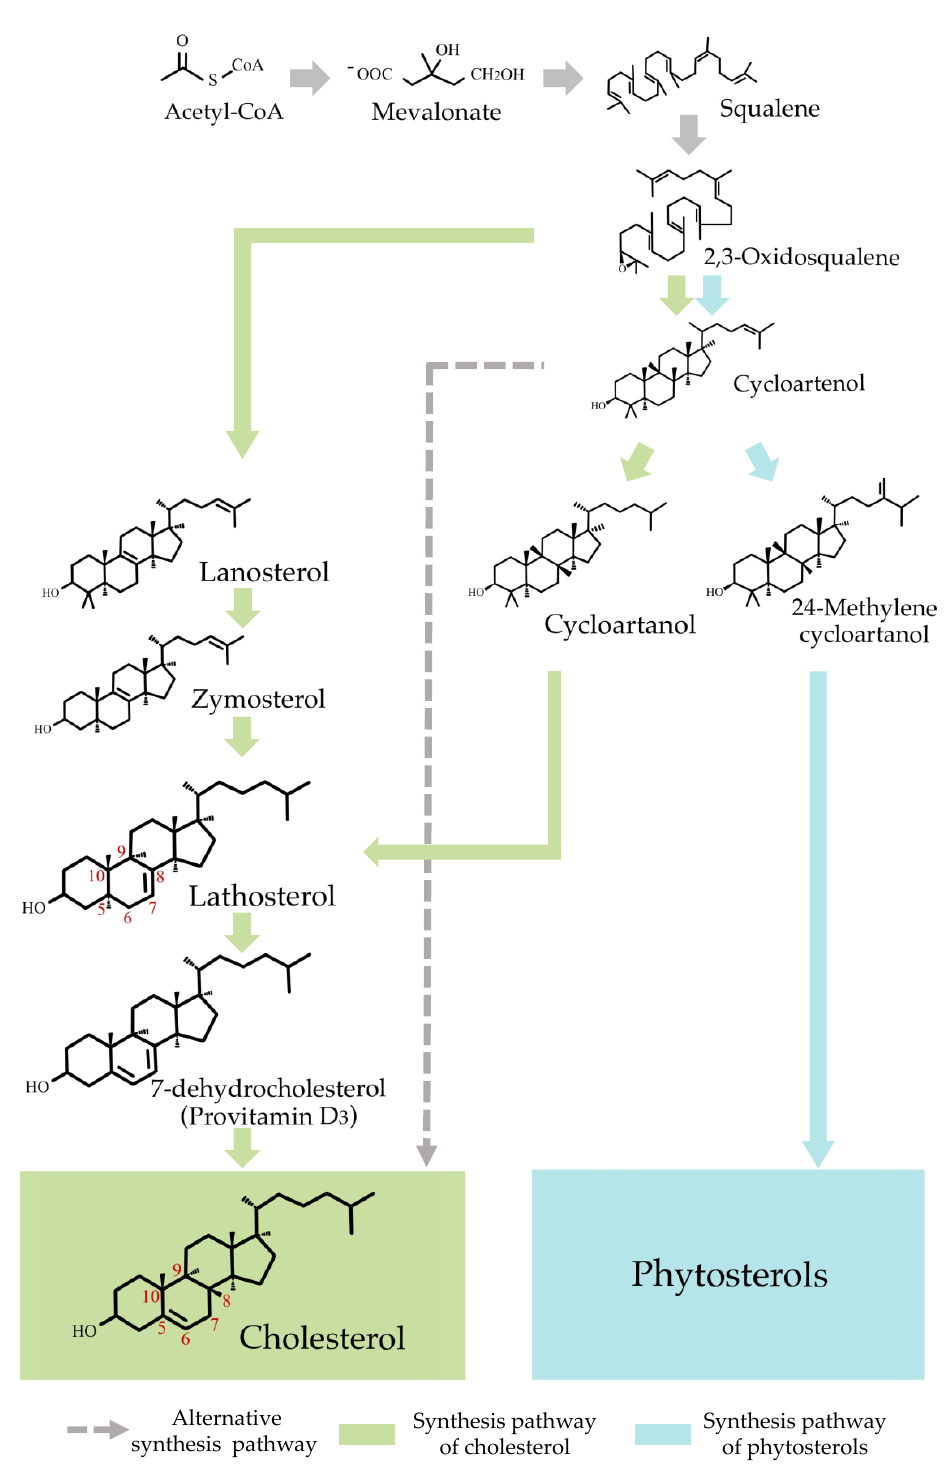
Figure 5. Suggested cholesterol synthesis pathway in algae and plants. This Figure is adapted from Sonawane et al. [21], Yoshida et al. [39], and Belcour et al. [40].